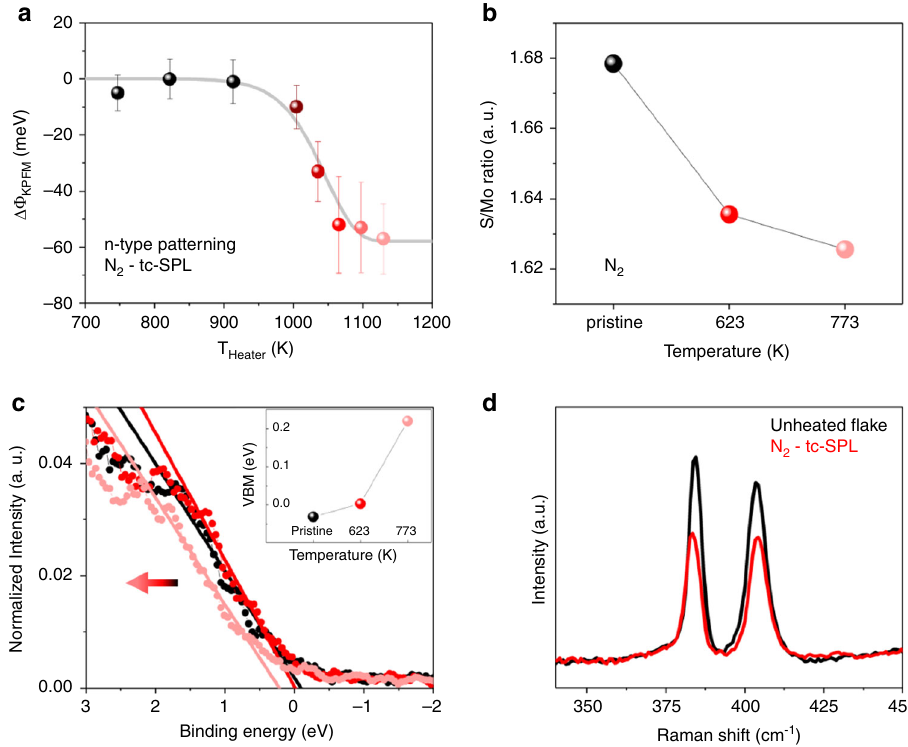
Fig. 5 tc-SPL in N 2 atmosphere. a Work-function difference ΔΦ KPFM = Φ pattern – Φ non-patterned vs. absolute temperature and corresponding data fi t with Eq. (1) (shown as a gray line). The error bar is standard deviation of KPFM data within the area of analysis. b Stoichiometry of single-layer CVD MoS 2 in pristine conditions (data in black) and heated at two temperatures (623 K, data in red and 773 K, data in pink) in N 2 atmosphere, as obtained by XPS core levels spectra. c XPS valence band spectra (normalized to area) close to the Fermi edge for the same samples. The horizontal arrow indicates the direction of the shift toward higher binding energy with increasing n-character and temperature. Inset shows the valence band maximum evolution as a function of the temperature. d Raman spectra collected inside (data in red) and outside (data in black) a tc-SPL pattern in single-layer CVD MoS 2 XPS of N – heat-activated n-type defects . In order to explain the 2 temperature-induced decrease of work function in N 2 atmo- sphere, we perform XPS on globally heated CVD MoS 2 samples (Fig. 5b, c) and Raman spectroscopy (Fig. 5d) inside and out- side locally heated N 2 – tc-SPL patterns. Elemental analysis from XPS (Fig. 5b) shows that the S/Mo ratio in monocrystalline single-layer CVD MoS 2 is lower than 2 and decreases with the temperature. This decrease is associated with S-vacancies, which increase for the samples heated at higher temperatures 14 ( T = 623 K and 773 K). The XPS VB spectra and the VBM values as measured with respect to the Fermi level show a shift toward higher binding energies (the Fermi level moves away from the VB) with the increase of temperature (Fig. 5c), in agreement with the decreased ΔΦ measured by KPFM (Fig. 5a). This indicates a higher n-type character induced by local heating in N 2 atmosphere. Raman spectra collected inside (data in red) and outside (data in black) a 2 × 2 µm 2 tc-SPL-patterned area in N 2 atmosphere (Fig. 5d) also con fi rm the presence of n- type defects in N 2 – tc-SPL patterns. In this case, we do not observe any shift of the A 1g peak, while the E 1 2g peak shows a slight red shift of ∼ 0.7 cm − 1 . Furthermore, both A 1g and E 1 2g peaks have lower intensities compared with the unheated fl ake. Red shift of the E 1 2g Raman peak accompanied by lower peak intensity and peak widening of the A 1g and E 1 2g peaks and attributed to the formation of S-vacancies and lattice deformation 45,50 . We also notice that the extracted energy difference between A 1g and E 1 2g peaks is ∼ 20 cm − 1 , as expected for a monolayer CVD sample 53 .